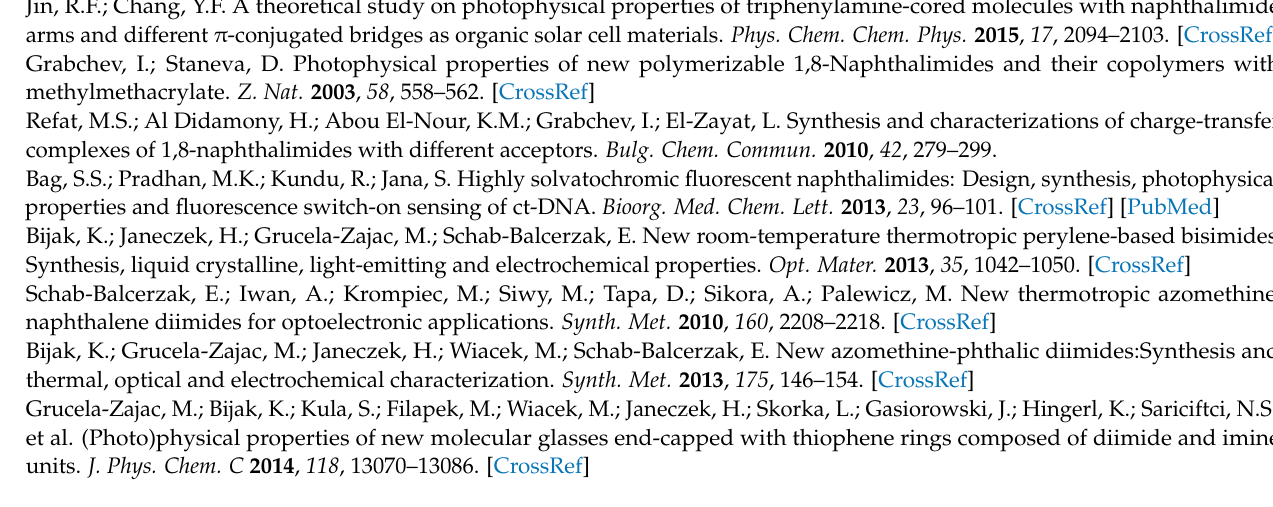
data, Figure S2: 1HNMRof the investigated compounds (400 MHz, CDCl3), Figure S3: 13C NMR of the investigated compounds (400 MHz, CDCl3), Figure S4: HMQC and COSY correlation spectra for 1a (400 MHz, CDCl3), Figure S5: The investigated compounds under (a) 1a, (c) 1c,(d) 1d day light and (b) 1a under UV-light, Figure S6: DSC thermograms of (a) 2a, (b) 3a and (c) 4b, Figure S7: The (a) reduction and (b) oxidation processes of 2a, 3a, 4b (Pt, v= 0.1 V/s, 0.1 mol/dm3 Bu4NPF6 in CH2Cl2 with 10 − 3 mol/dm3 of compounds), Figure S8: Optimized geometries of the compounds (a) 1a, (b) 2a, (c) 3a, (d) 1c, (e) 1d, (f) 4b, Figure S9: Contours of HOMO and LUMO of the compounds (a) 1a, (b) 2a, (c) 3a, (d) 1c, (e) 1d, (f) 4b, Figure S10: Density-of-states diagrams of ground state of the molecules, Figure S11: Experimental and calculated UV-Vis spectra of bis-(imino-1,8-naphthalimide) derivatives, Table S2: Calculated dipole moments (in CHCl3) and geometrical parameters of the molecules in ground and first singlet excited state, Table S3: Composition of the selected MO in ground state of the compounds, Table S4: The calculated electronic transitions corresponding to excitation resulting most intense luminescence in CHCl3 solution, Figure S12: (a) 1a and (b) 1d under day light and under UV-light ( λ = 366 nm) in NMP, Table S5: PL life-time ( τ ) measurements data, Figure S13. PL life-time ( τ ) curves of (a) 2a, (b) 3a and (c) 4b in chloroform solution, Figure S14. Emission spectra of (a) 2a; (b) 3a; (c) 4b and (d) 1c with PVK:PBD., Figure S15. Emission spectra of 1a and PVK:PBD, Table S6. EA, IP, HOMO, LUMO, Eg and Egopt, Figure S16. Electroluminescence (EL) spectra of the working devices under an applied voltage. Above the graphs the device structures are shown. Presented are maxima of EL